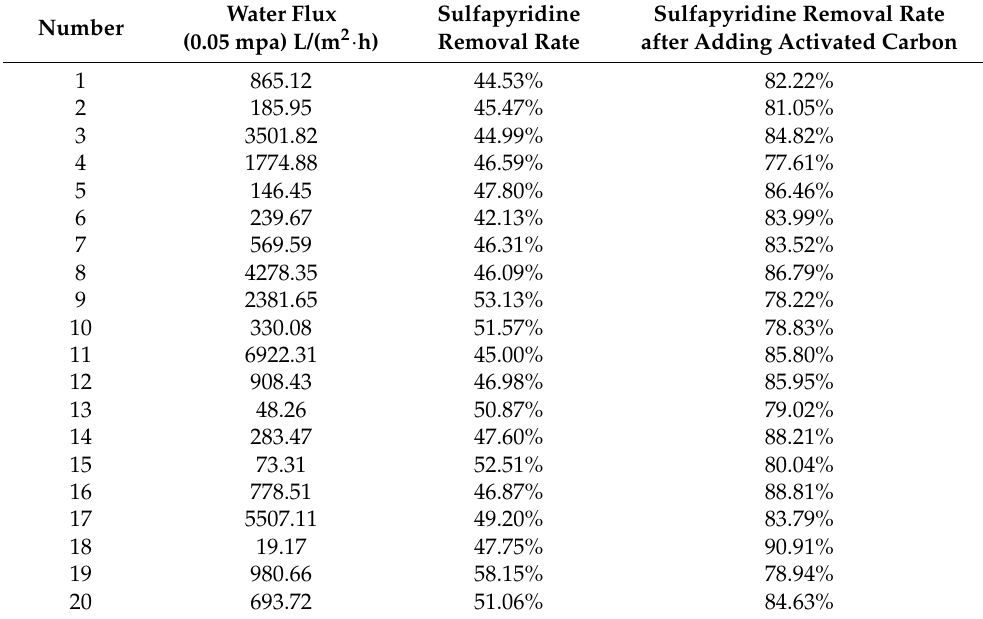
Table 3. Box–Behnken test